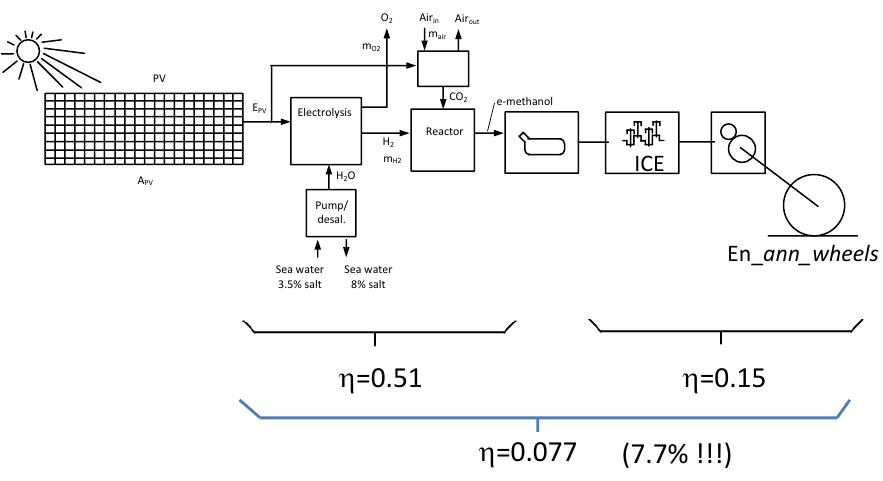
Figure 7. Efficiency of the e-methanol-powered ICE vehicle.